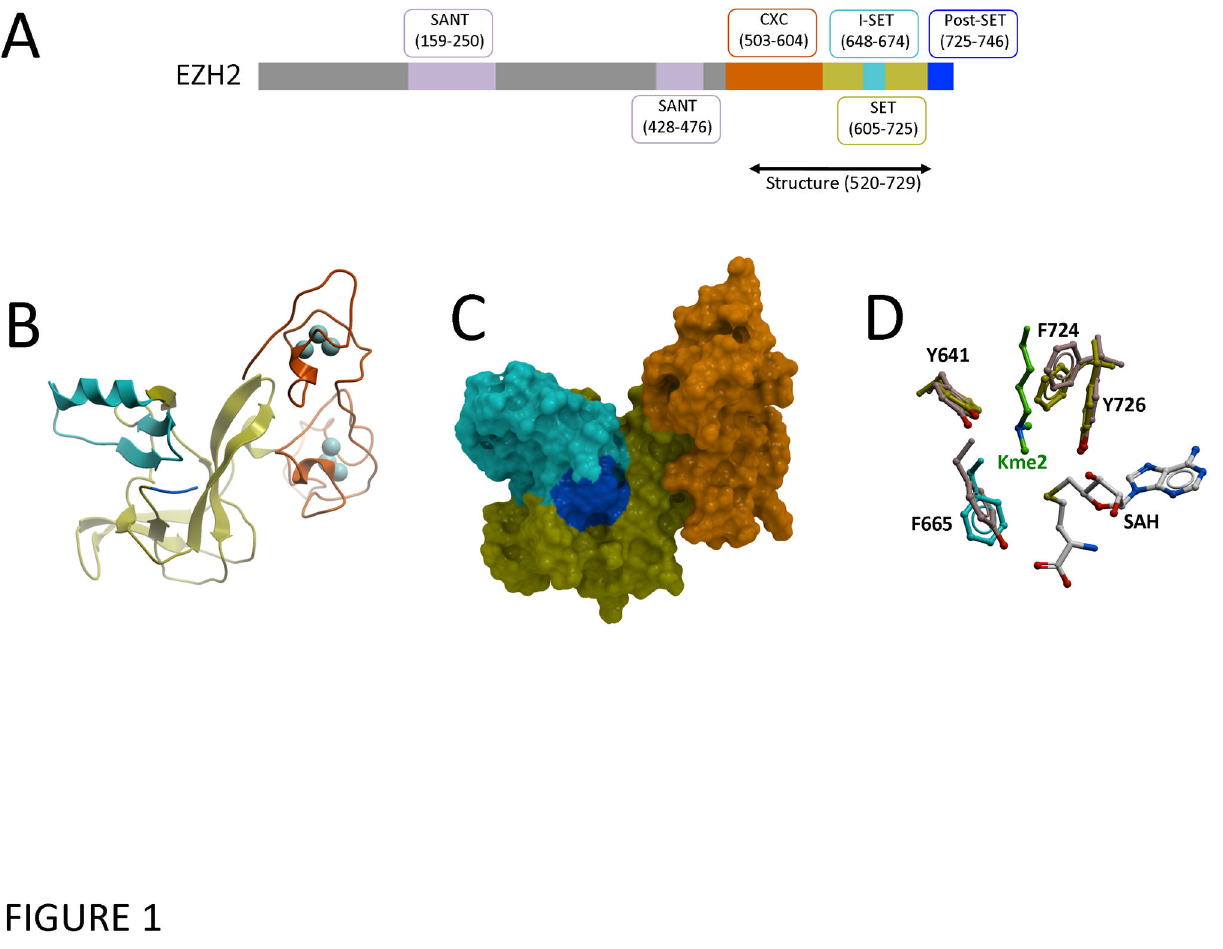
Figure 1. EZH2 adopts the canonical fold of SET domain methyltransferases. (A) Linear domain architecture of EZH2 showing the crystallized construct. Residue numbers according to GenBank isoform C (Uniprot isoform 1). (B) The catalytic SET domain (yellow) is folded as previously described for other histone methyltransferases such as EHMT1/GLP and MLL, but the post- SET domain is largely unresolved and its first five residues (blue) are oriented away from its expected position. The unique CXC domain adopts a novel conformation including two clusters of three Zn ions (light blue spheres). (C) A mesh representation of